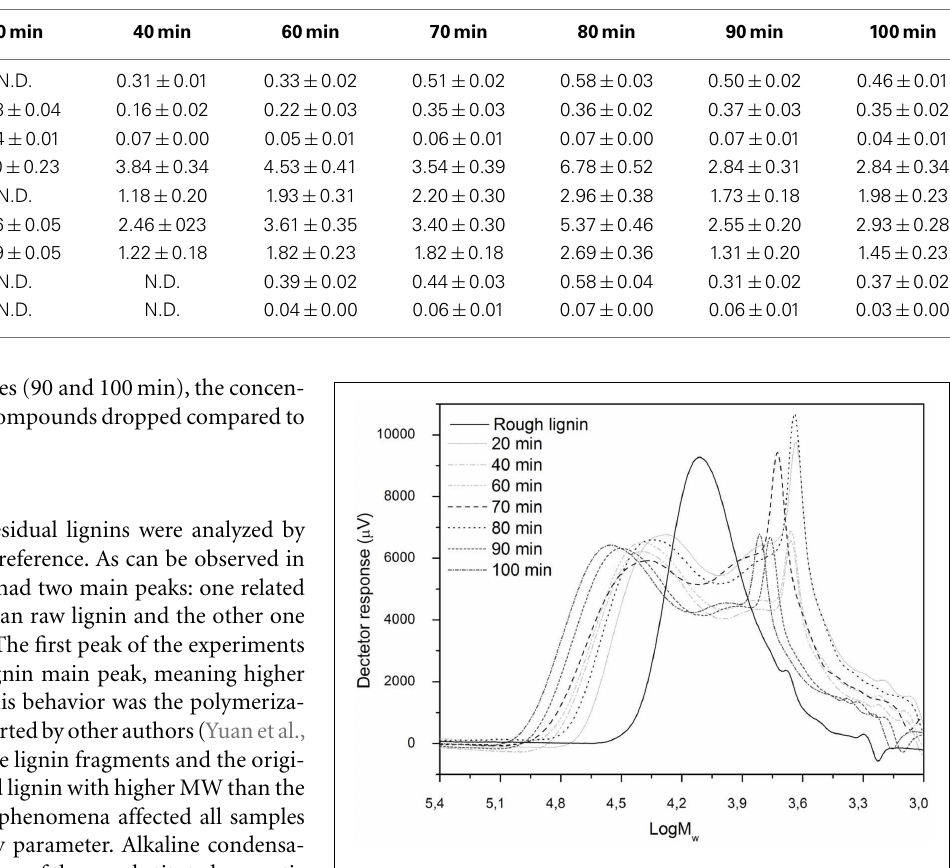
FIGURE 2 | Molecular weight distribution of raw lignin and residual lignins samples